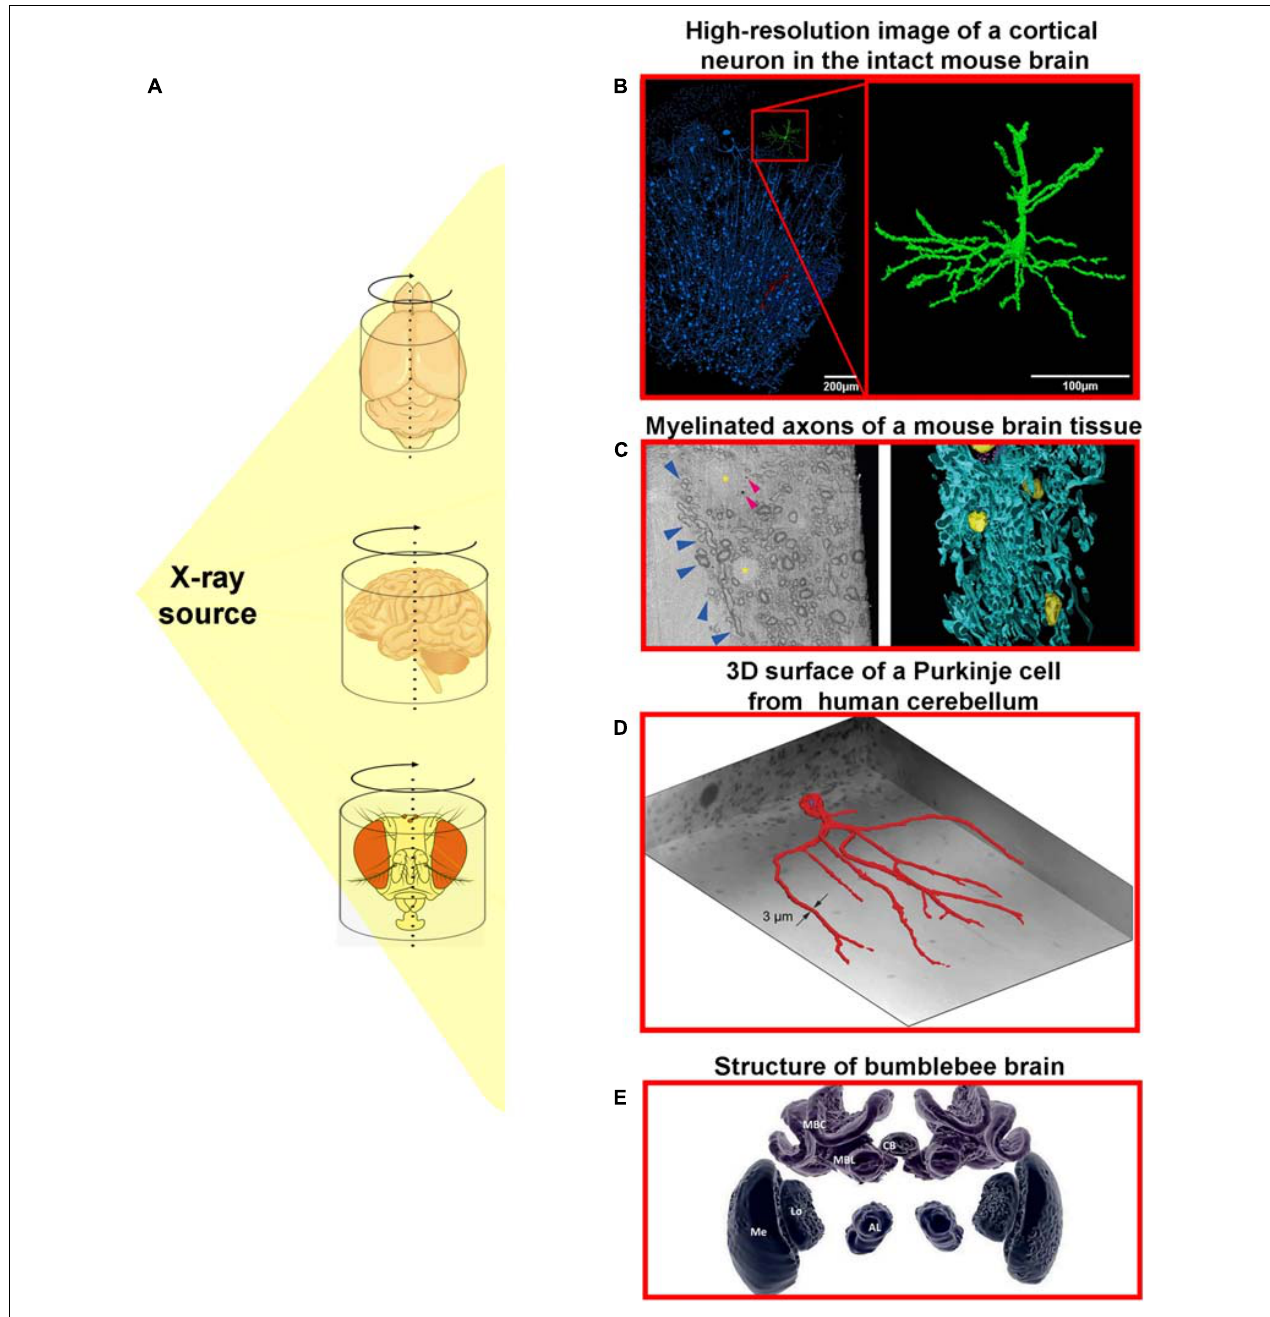
FIGURE 2 | Different x-ray microtomography techniques provide detailed three-dimensional information about nervous tissue architecture in high-resolution. (A) The x-ray from an x-ray source can be used to illuminate different samples of nervous tissue from different organisms. (B) High-resolution image of a highlighted cortical neuron (green) from the intact mouse brain (Fonseca et al., 2018). (C) Cryo x-ray ptychography and 3D color rendering of mouse brain tissue. (Left panel) represents a single orthoslice from a reconstructed 3D tomogram. Blue arrowheads show variations of myelin sheath thicknesses of myelinated axons. Yellow asterisks mark multiple cell nuclei and small and roughly spherical structures are pointed by arrowheads. (Right panel) portrays the semi-automated color segmentation of the reconstructed tomogram shown in the left panel, based on the contrast differences within the sample. Yellow = nuclei, blue = myelinated axons (Shahmoradian et al., 2017). (D) Representation of the 3D surface of a Purkinje cell in the human cerebellum including its dendritic tree (Hieber et al., 2016). (E) 3D image of individually segmented brain structures of the bumblebee ( Bombus terrestris ): central body (CB), and one of the pair of lobulas (Lo), medullas (Me), antennal lobes (AL), mushroom body calyces (MBC), and mushroom body lobes (MBL). This figure was adapted from Hieber et al. (2016); Smith et al. (2016), Shahmoradian et al. (2017); and Fonseca et al. (2018) under the Creative Commons License 4.0 (CC-BY) (http://creativecommons.org/licenses/by/4.0/). Cartoons used